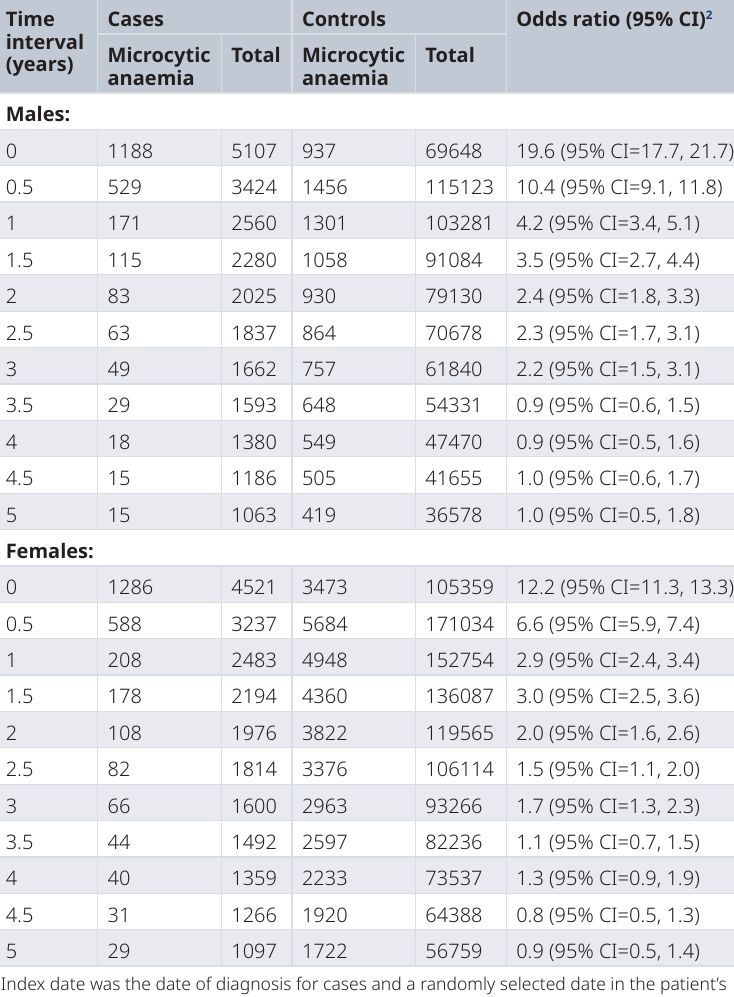
Table 12. Adjusted odds ratios for diagnosis between patients with and without microcytic anaemia at six-monthly (+/- three months) time intervals prior to index date 1 .